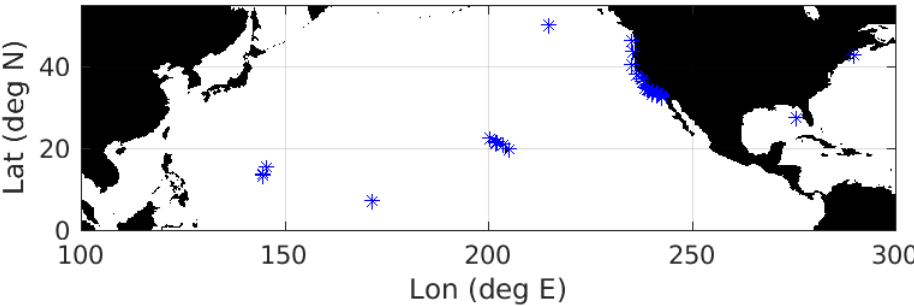
Figure 1. Locations of 34 analyzed Datawell buoys (blue asterisks).